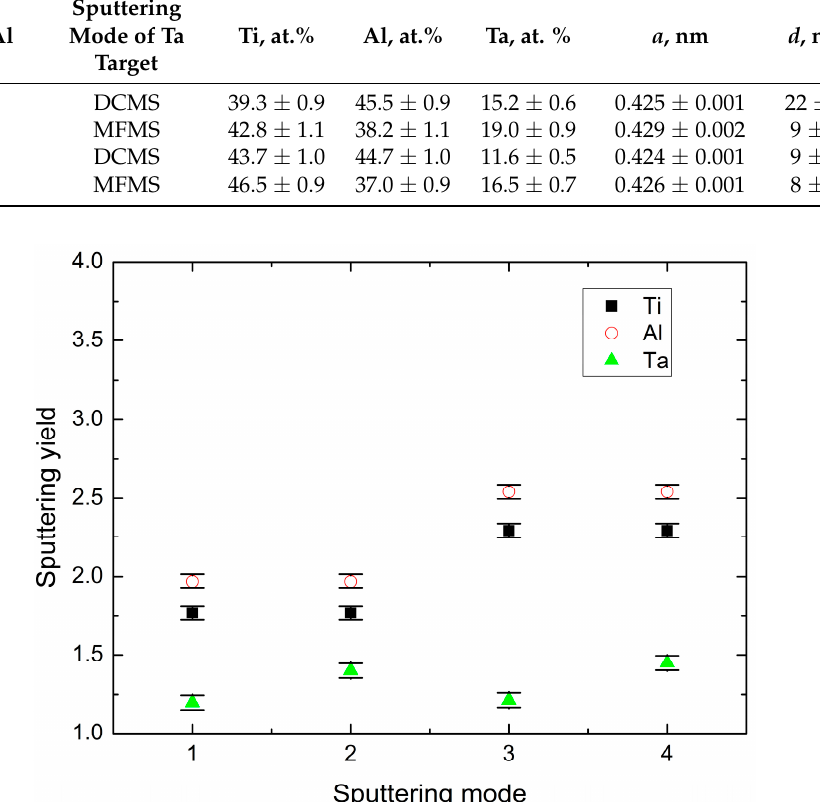
Figure 1. Sputtering yield of Ti, Al and Ta in different modes.